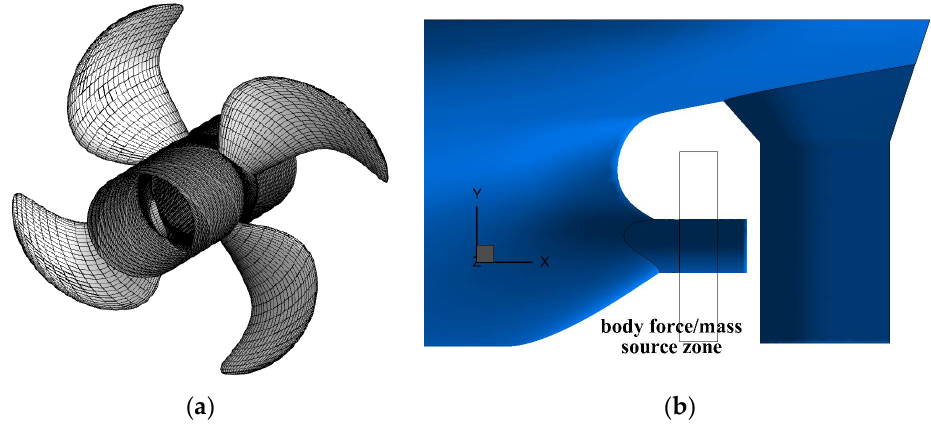
Figure 5. Propeller geometry generated via ( a ) BEM and ( b ) Mass/Body force zone in RANS. J. Mar. Sci. Eng. 2018 , 6 , x FOR PEER REVIEW